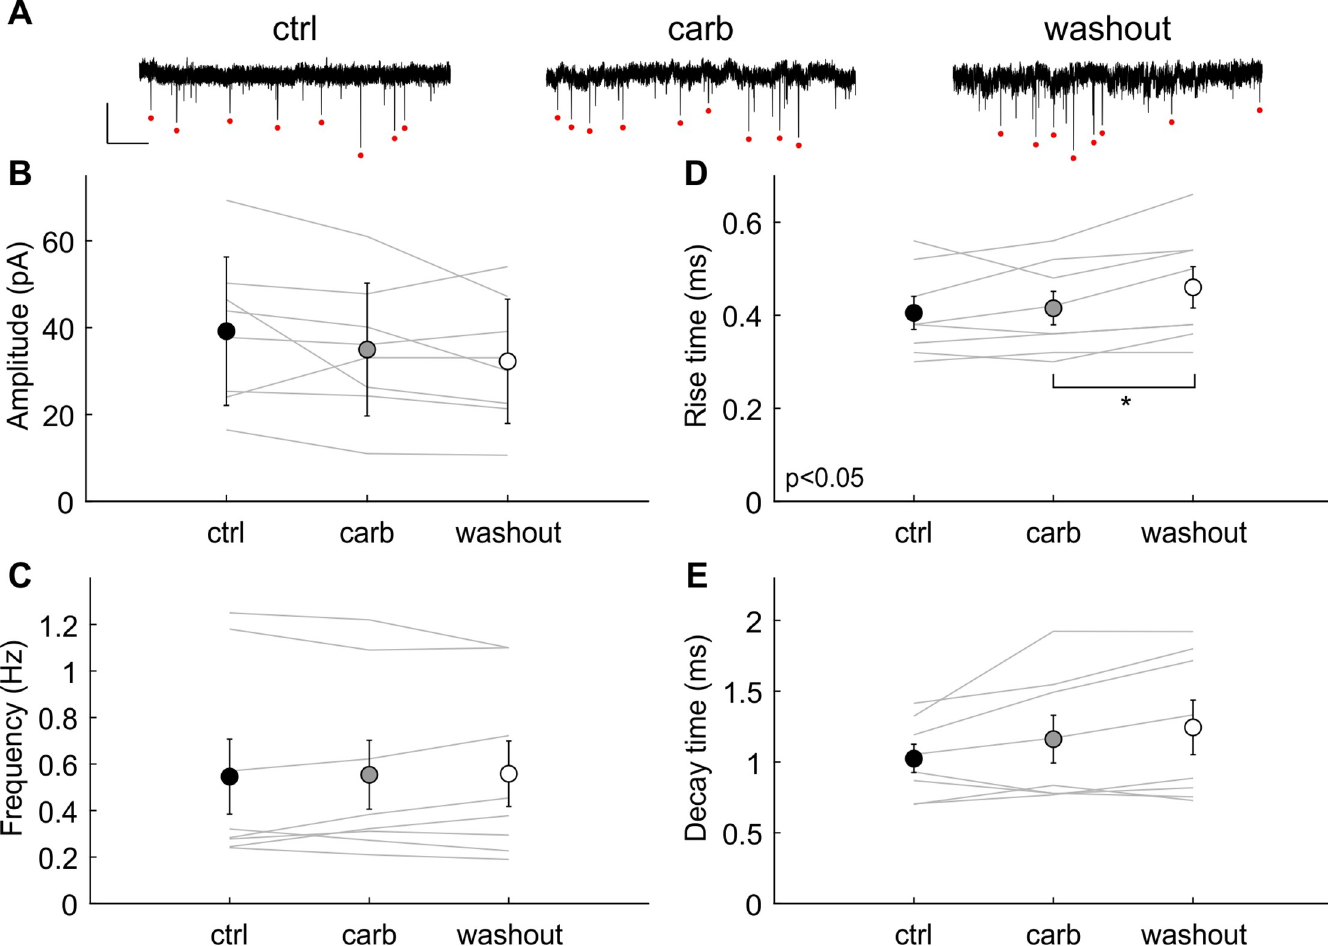
Fig 8. No influence of carbachol on spontaneous mEPSCs. (A) Example traces of recorded mEPSCs in control condition (ctrl, left part), in presence of carbachol (carb, middle part) and after washout carbachol (washout, right part); scale: 2 s/50 pA. The red dots represent the automatically detected mEPSCs. (B) Average amplitude, (C) average frequency, (D) average rise time and (E) average decay time of mEPSCs before, during and after washing out carbachol. No difference was observed between the three conditions for amplitude and rise- or decay kinetics. Although there was a significant difference between carbachol and wash-out for the mEPSC rise-time (asterisk in D) the effect was only very